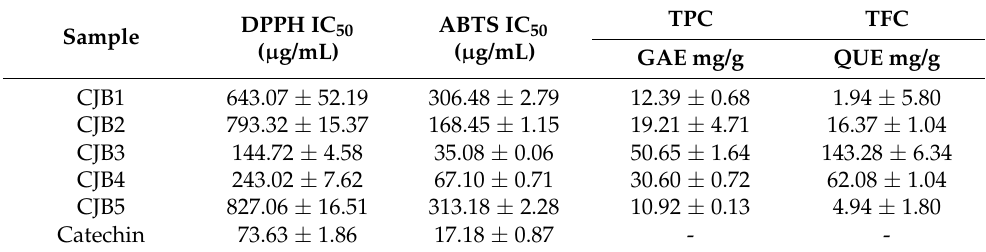
Table 1. Total polyphenol content (TPC) and total flavonoid content (TFC) of CJBs.